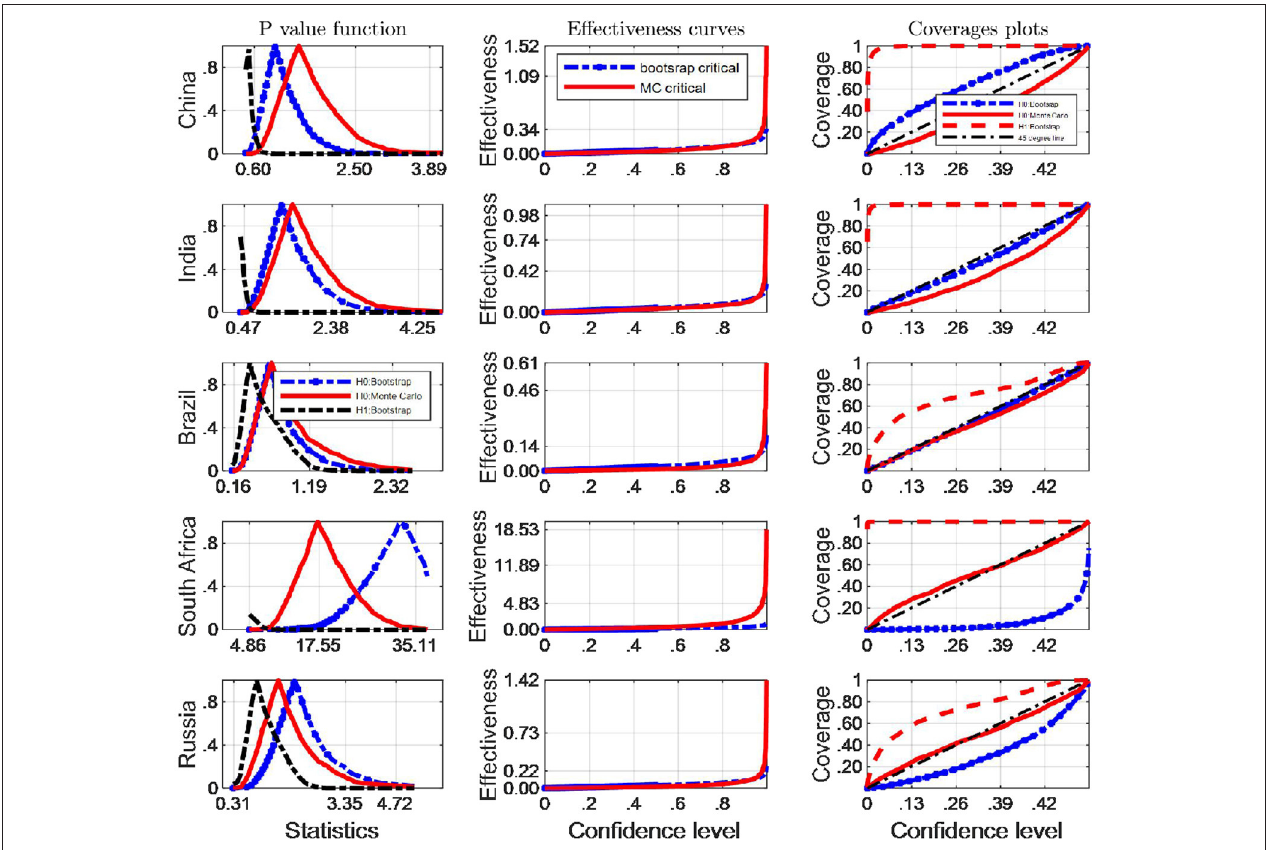
FIGURE 6 | A comparison of confidence intervals of Monte Carlo and counterparts of bootstrap for the Mayoral test using BC